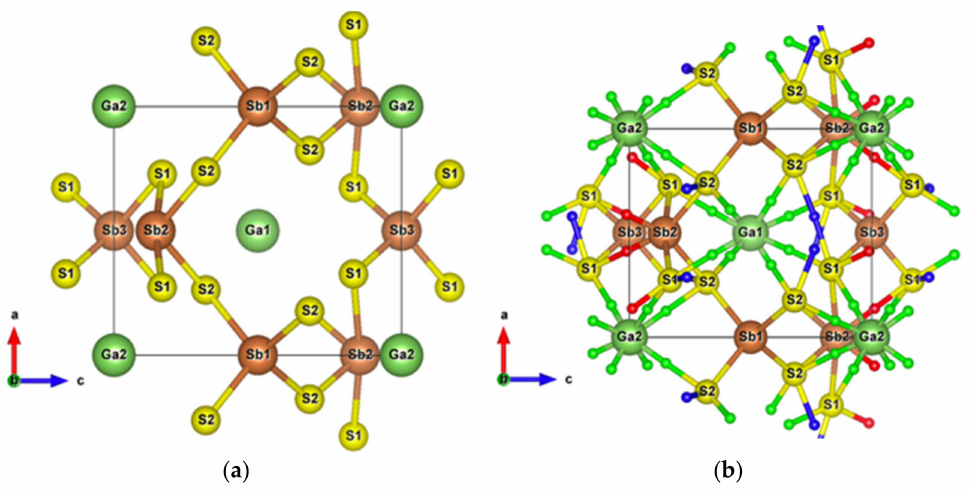
Figure 13. ( a ) Unit cell of SbS 2 Ga 2 ; ( b ) Crystal structure of SbS 2 Ga 2 showing the weak interactions. Small red, blue, and green balls are BCPs of Sb–S, S–S, and Ga–S interactions,